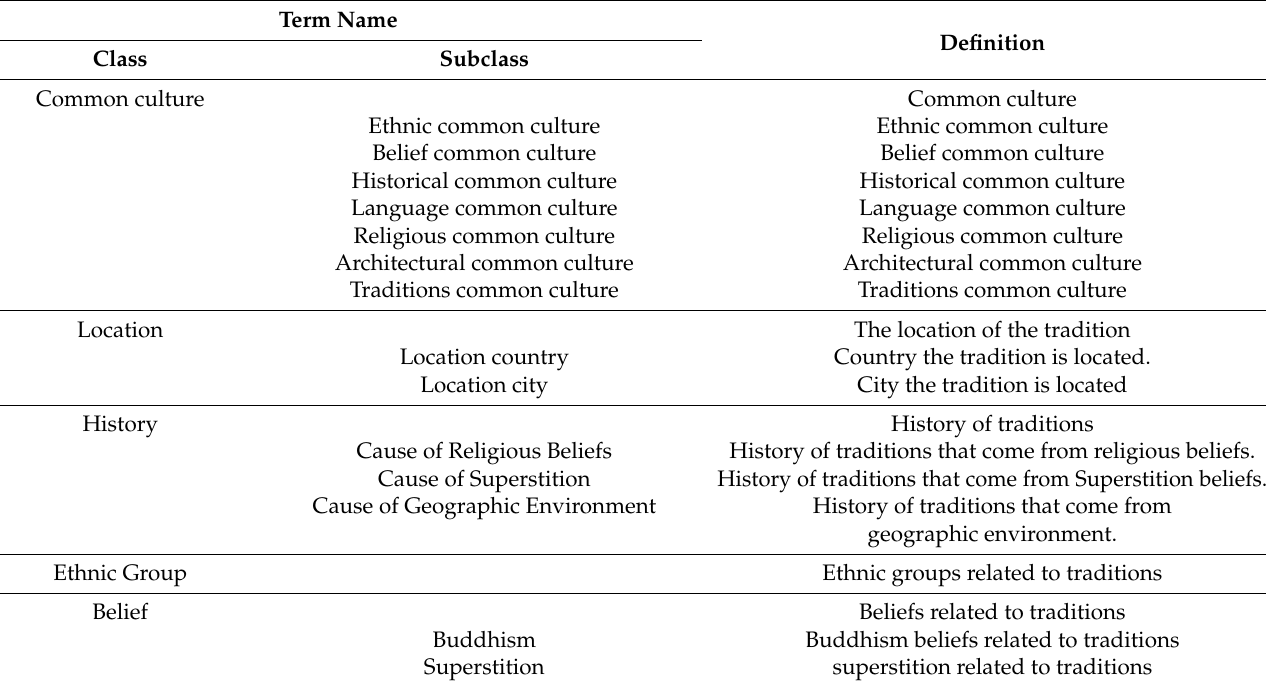
Table 1. The ontology of the traditions common culture in the GMS